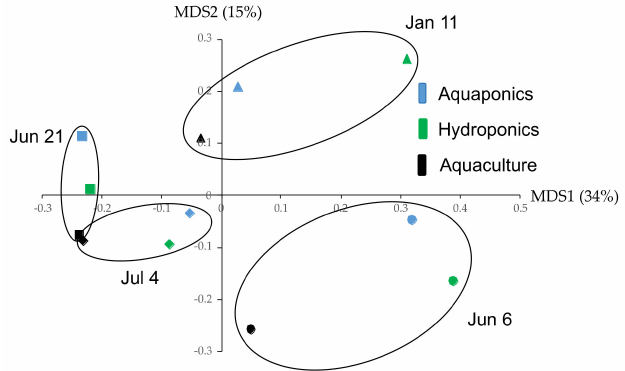
Figure 5. Principal coordinate analysis presenting the separation among Exp. 1 (January 11: 5 weeks) and Exp. 2 (June 6: 2 weeks, June 21: 4 weeks, and July 4: 6 weeks). MDS 1 and 2 explain % of the total